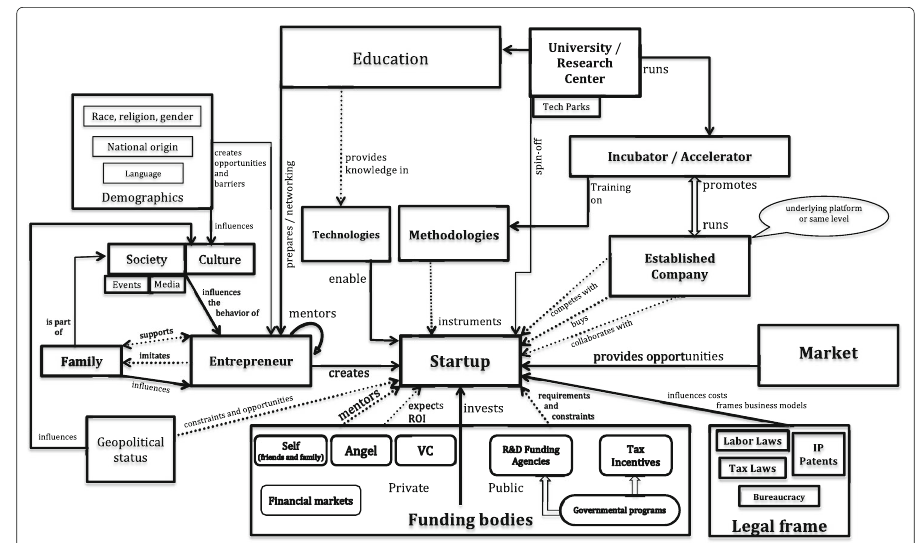
Fig. 3 Startup ecosystem conceptual